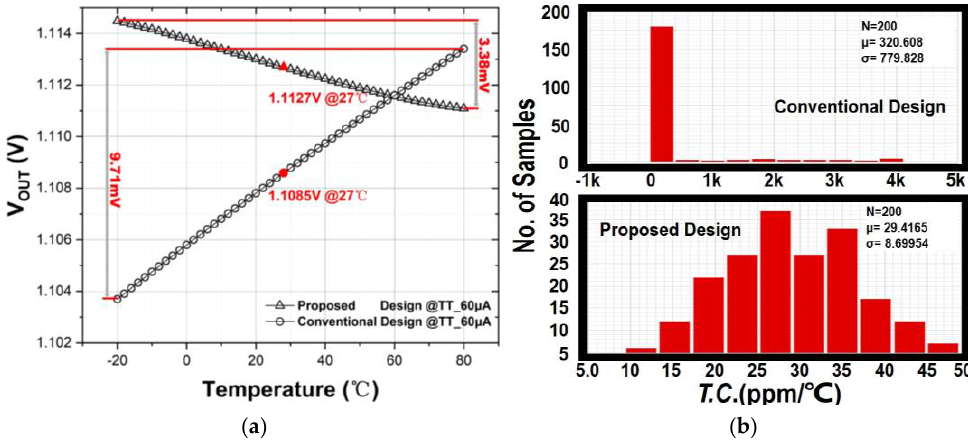
Figure 16. Comparison between conventional design and proposed work of ( a ) temperature characteristic of V OUT under nominal case; ( b ) Monte-Carlo simulation of T.C. of V OUT .